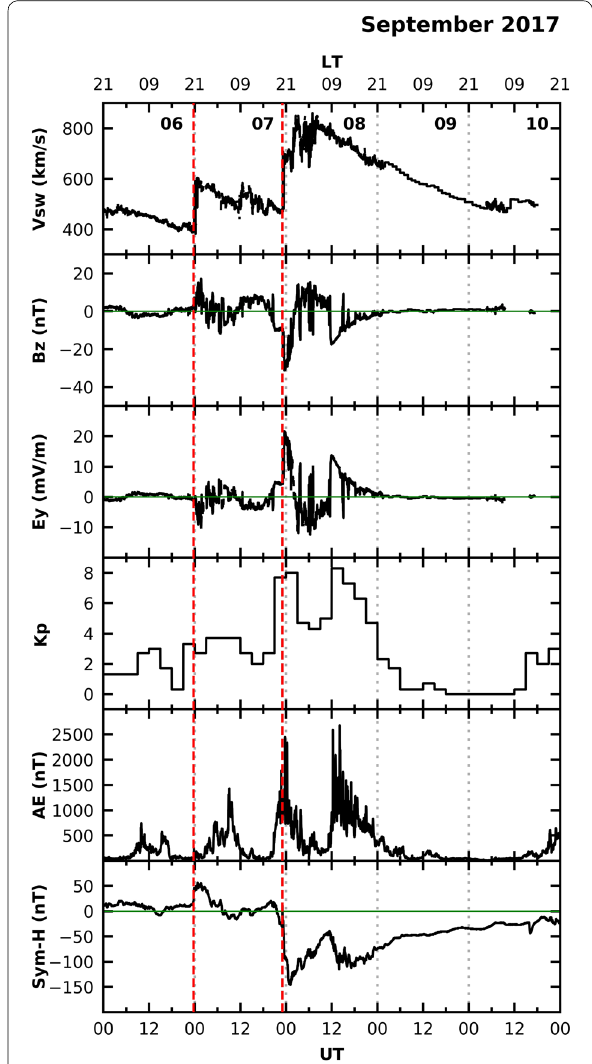
Fig. 1 Solar wind speed Vsw, north–south IMF component B z , interplanetary east–west electric field E y (positive to east), magnetic indices K p , AE and Sym-H for the period of 06–10, September 2017. Vsw, B z and E y hourly data for days 09 and 10 were used when 1-min data were not available. The vertical dashed red lines represent the 2 SSCs. The LT axis for the geographic longitude of 45°W is plotted at the upper panel (LT =